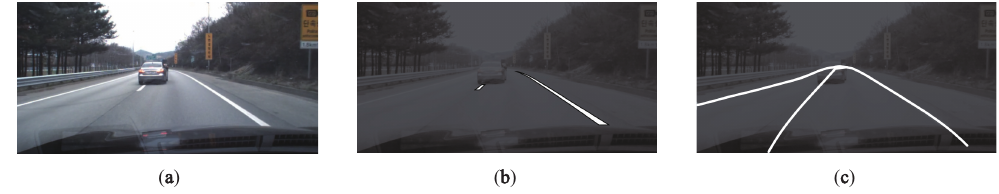
Figure 1. Example for lane detection output difference according to approaches. ( a ) Original Image, ( b ) Feature-based Lane Detection, ( c ) Learning-based Lane